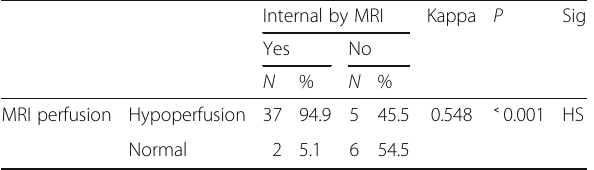
Table 4 Agreement between MRI of the brain and MRI perfusion as regards diagnosis of watershed infarction site (internal and mixed) Internal by MRI